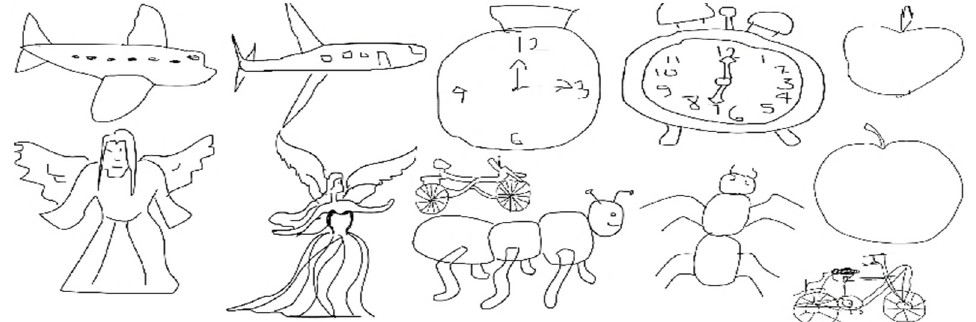
Figure 15. Randomly-selected image pairs from the TU Berlin dataset [43].